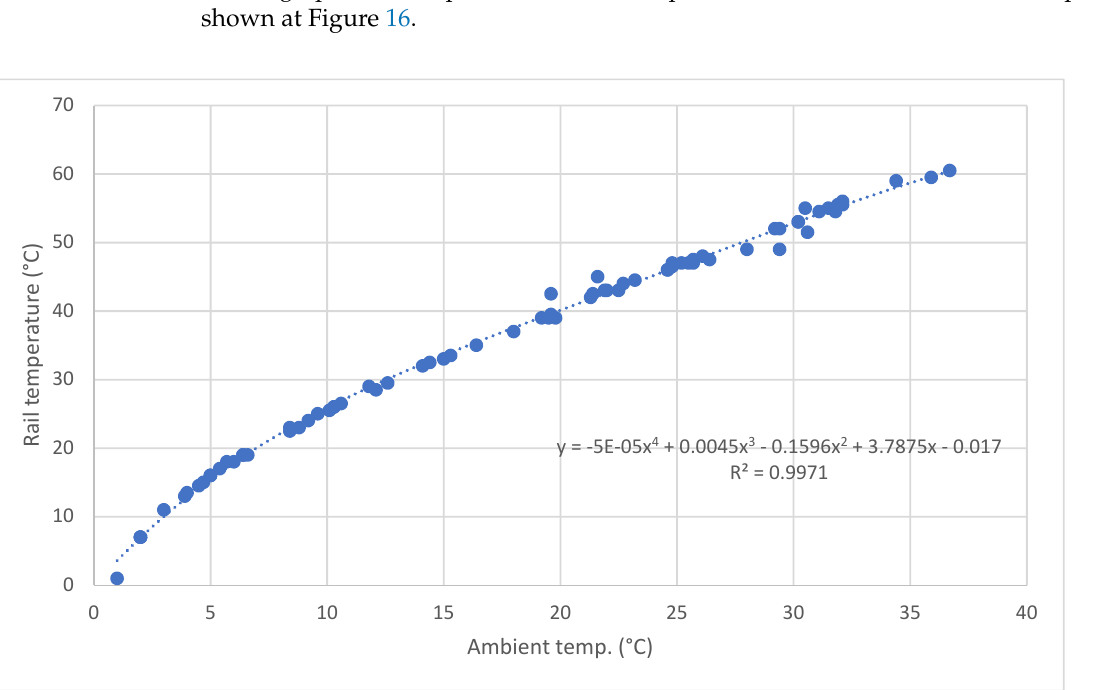
Figure 16. Temperature of the rail under load dependence on the ambient temperature (source: own